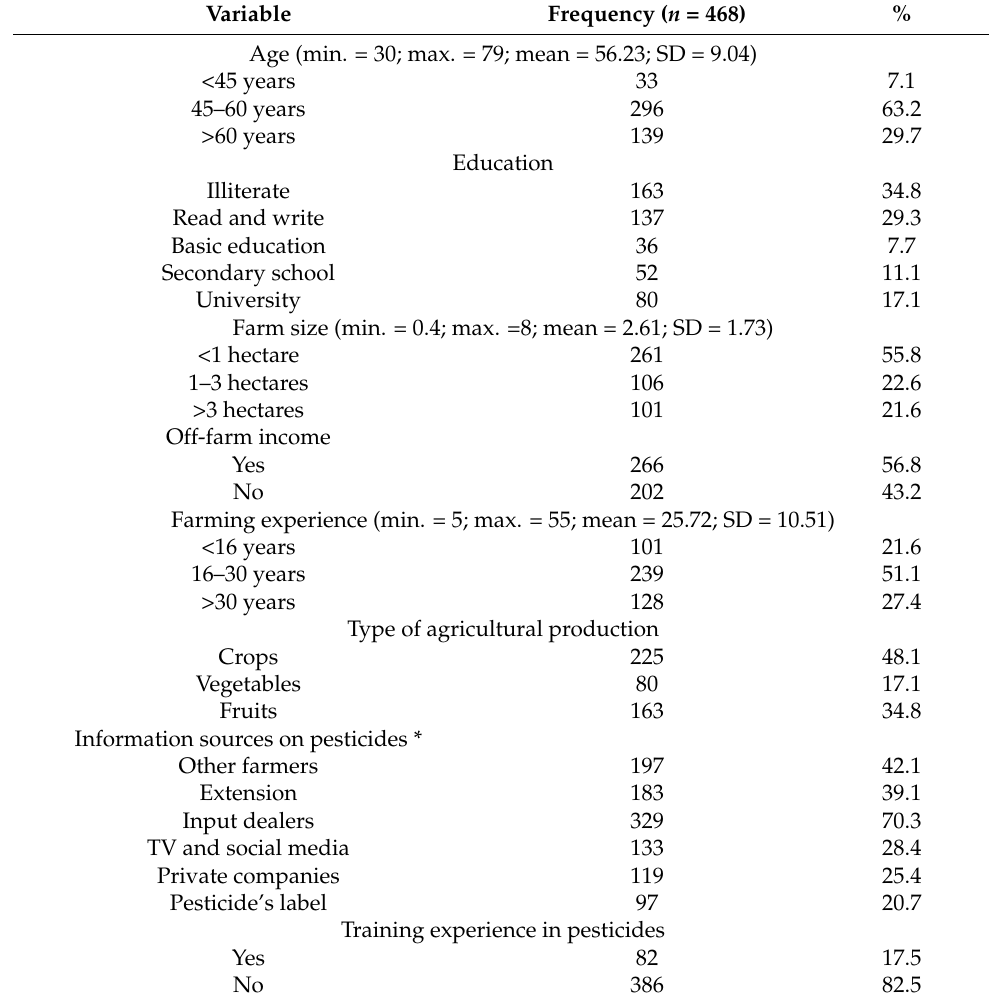
Table 2. Socioeconomic profile of the